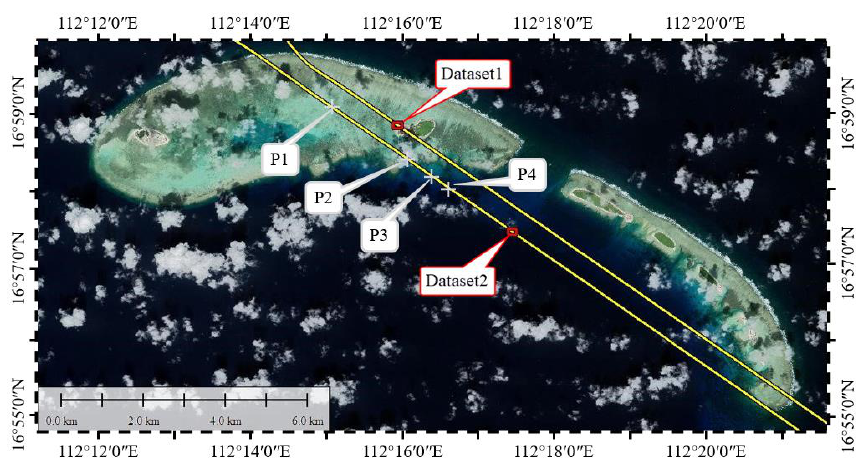
Figure 1. Study area. The yellow solid lines denote the distribution of the strips, the range of the datasets are in the red rectangles, and “ + ” denote the positions of the bathymetric points (P1– P4).